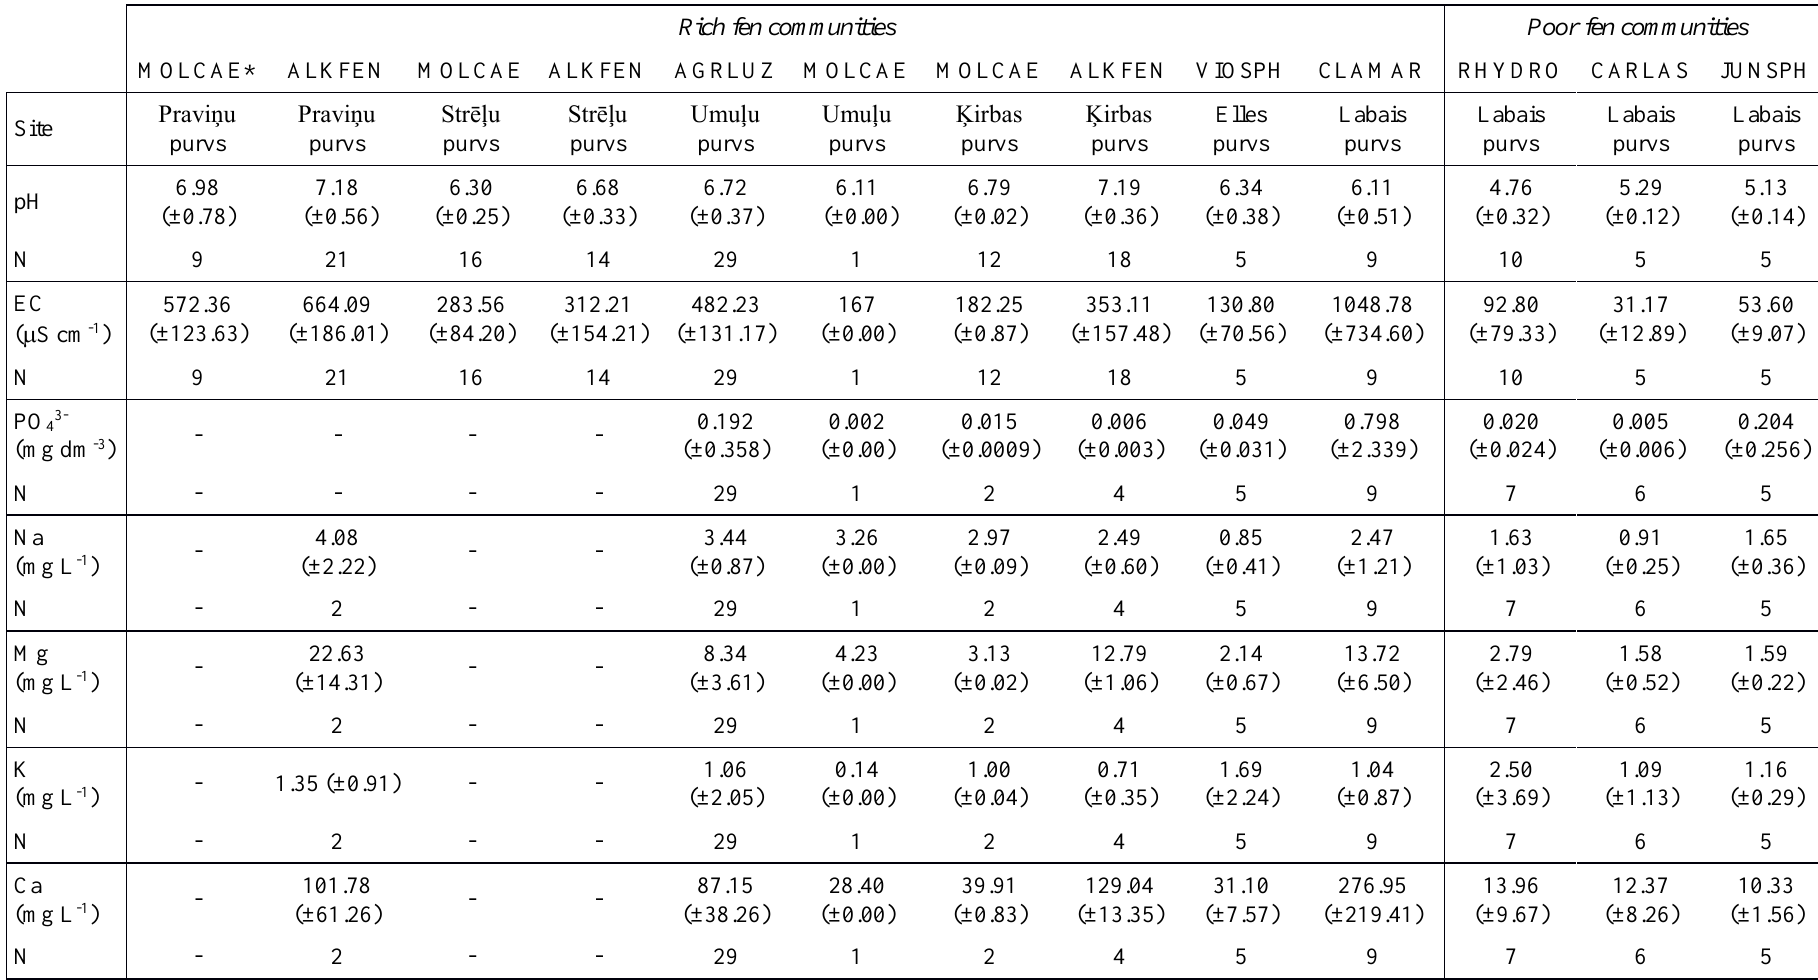
Table 4. Physical and chemical properties (mean values (± SD)) of soil water samples collected from the study sites. N = number of samples.